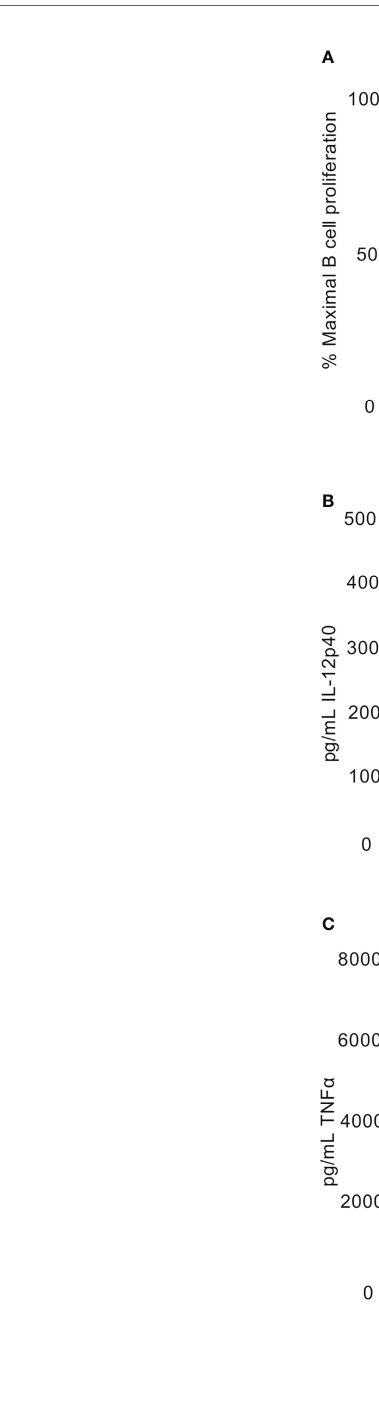
FIGURE 3 | Anti-CD40 11B6-CD40L fused to HIV-1 Gag p24, Nef, and Gag p17 or HPV16 E6/E7 antigens is highly active on human B cells and DCs. (A) Shows B cell proliferation in response to a dose range (shown left to right: 10, 1, 0.1, 0.01 nM) of the indicated antibody or antibody-antigen fusion protein; curves with gray fi lled square symbols are responses doses to the indicated antibody or anti-CD40 11B6-antigen fusion protein in the presence of 1 m g/ml (60 nM) soluble human CD40L or fused directly to CD40L. Data represent a single experiment normalized for maximum proliferation (95%) versus baseline proliferation without antibody (10%). (B, C) show MDDC cytokine secretion responses to a dose range (shown left to right: 10, 1, 0.1 nM) of each indicated mAb. Data show observed concentration values in pg/ml. The maximal values were IL-12p40, 359 ng/ml; TNF a , 6134 ng/ml. A dose range of the agonistic CP hIgG4 antibody is included for